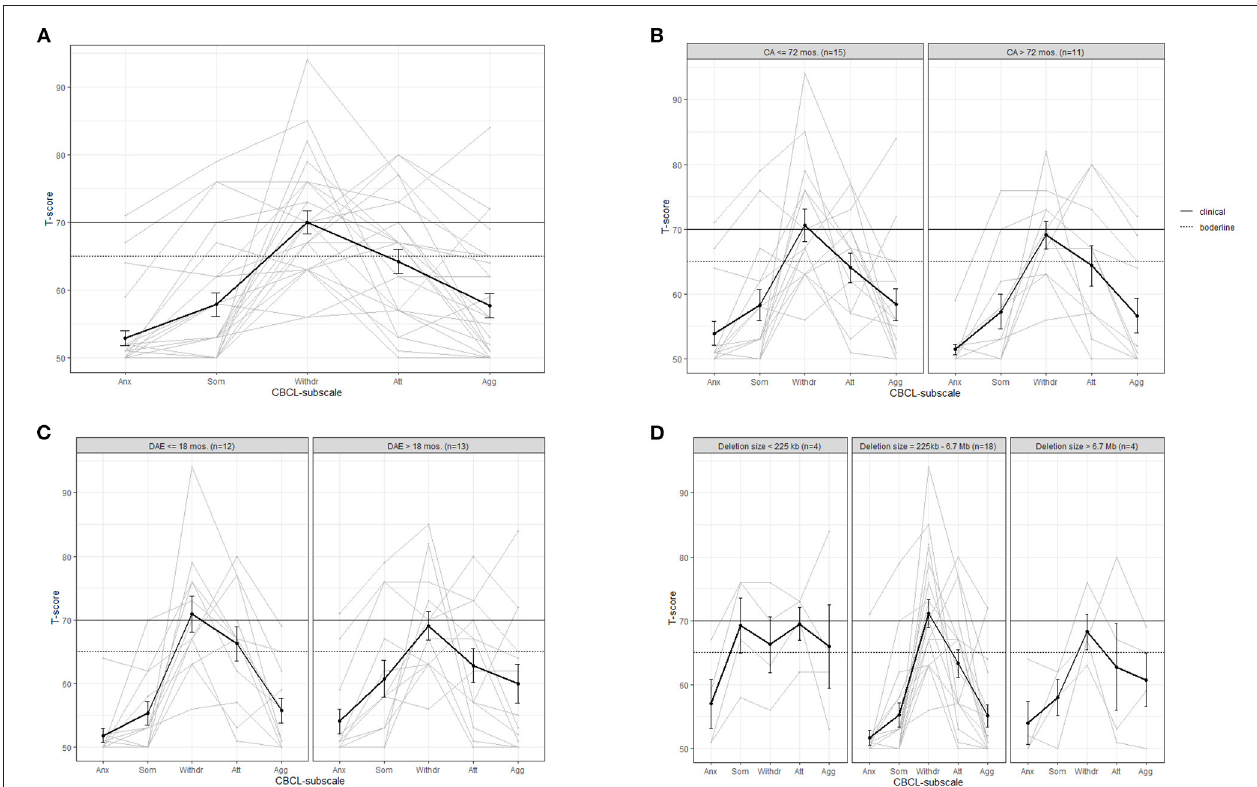
FIGURE 2 | Average (bold line) and individual behavior profiles on the CBCL subscales for (A) the whole sample and for subgroups based on (B) calendar age (CA), (C) developmental age equivalent (DAE) in months based on cognition scale Bayley-III and (D) deletion size. Anx, anxiety/depression; Som, somatic; Withdr, withdrawn; Att, attention problems; Agg, aggression.